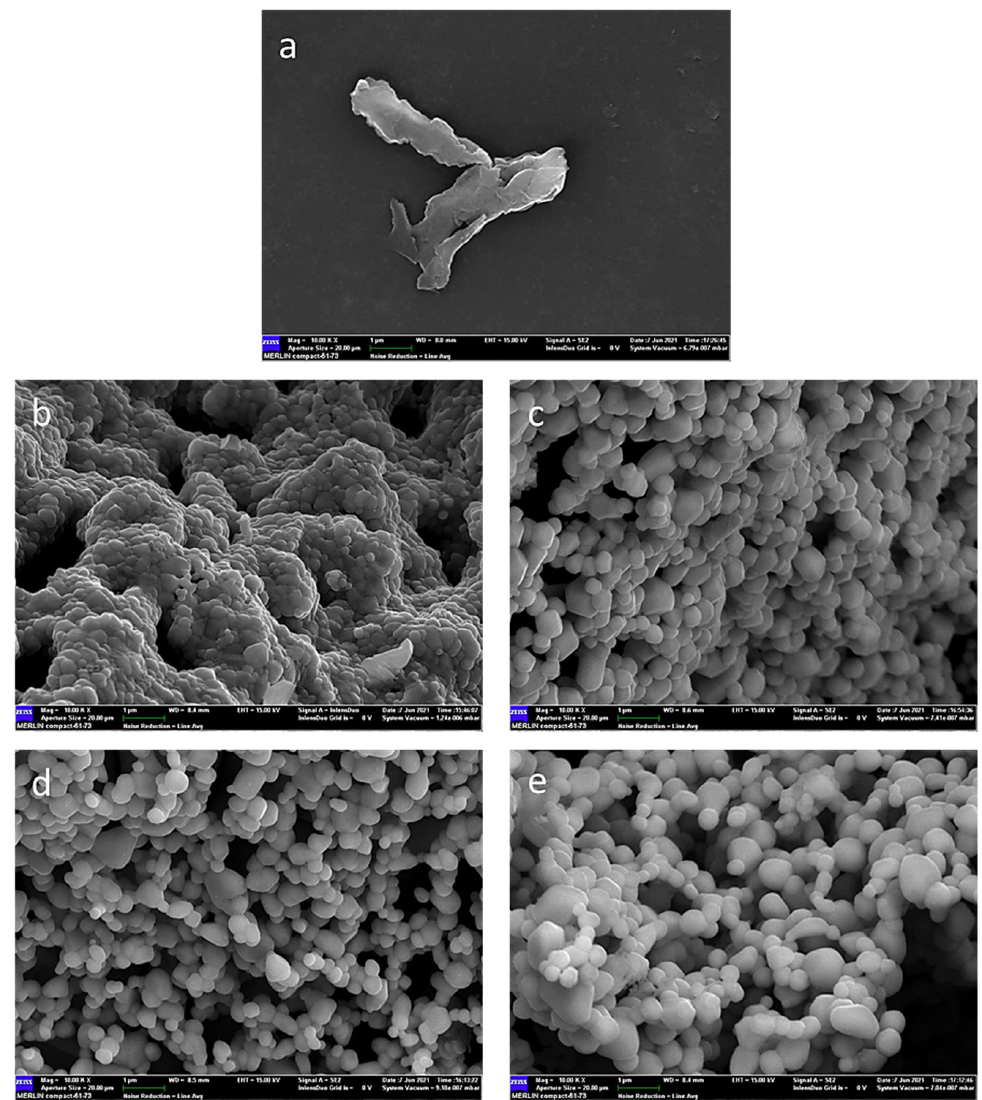
Figure 4. SEM images of prepared samples at temperatures of ( a ) room temperature, ( b ) 500, ( c ) 600, ( d ) 700, and ( e ) 800